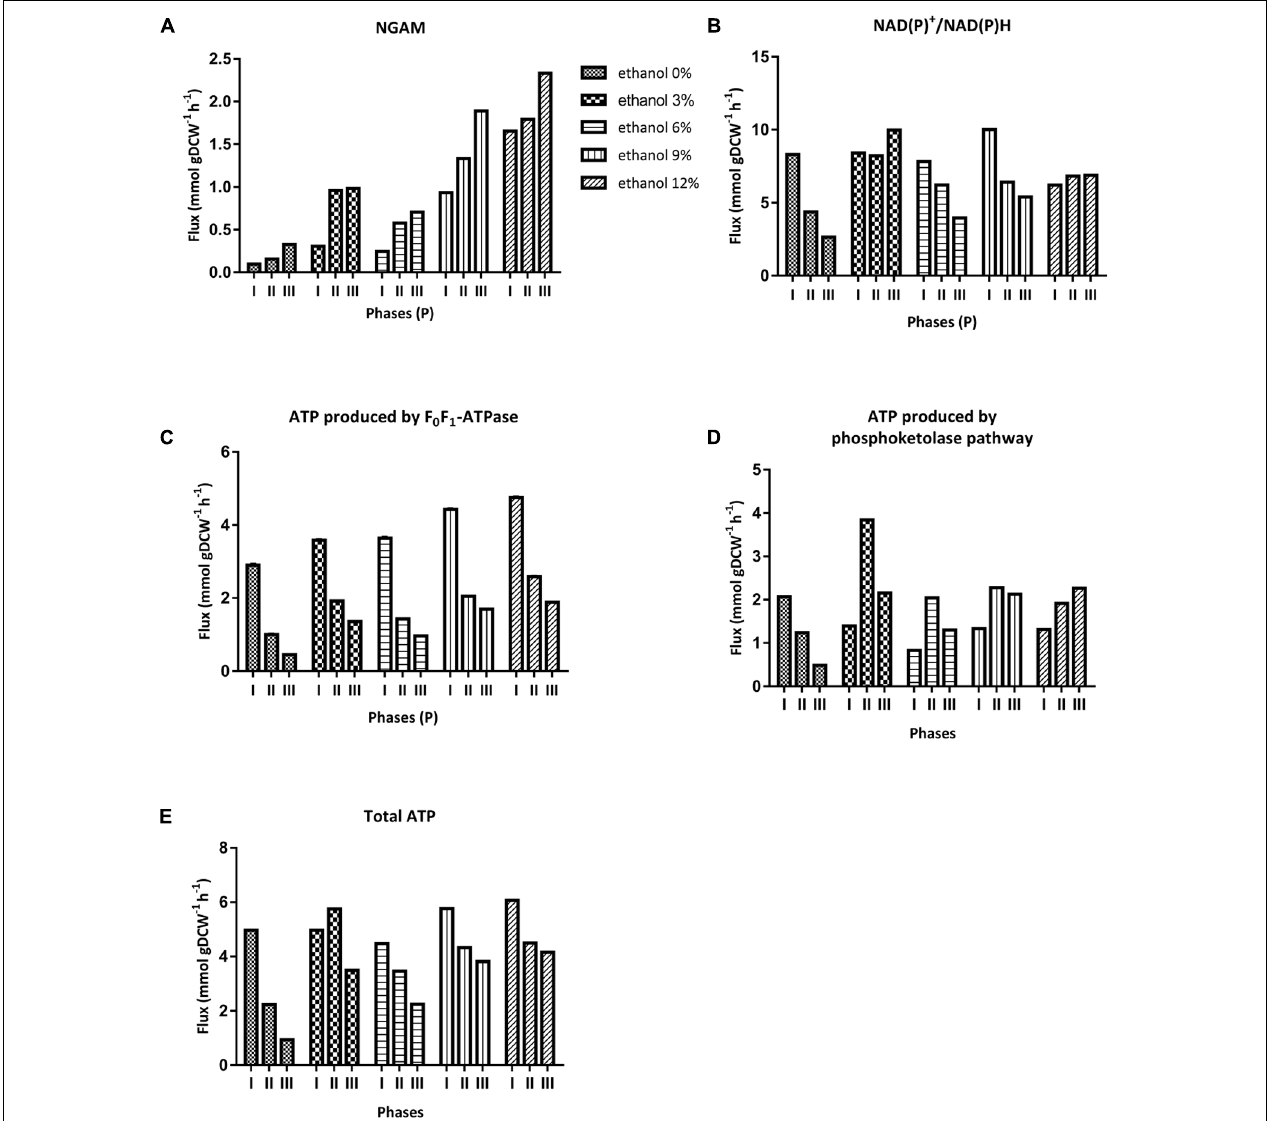
FIGURE 6 | Non-growth associated maintenance (NGAM) and in silico determined specific production rates of key metabolites of O. oeni. (A) NGAM, (B) NAD(P) + /NAD(P)H, (C) ATP produced by F 0 F 1 -ATPase, (D) ATP produced by phosphoketolase pathway, (E) Total ATP, (i.e.) ATP produced by both F 0 F 1 -ATPase and phosphoketolase pathways.